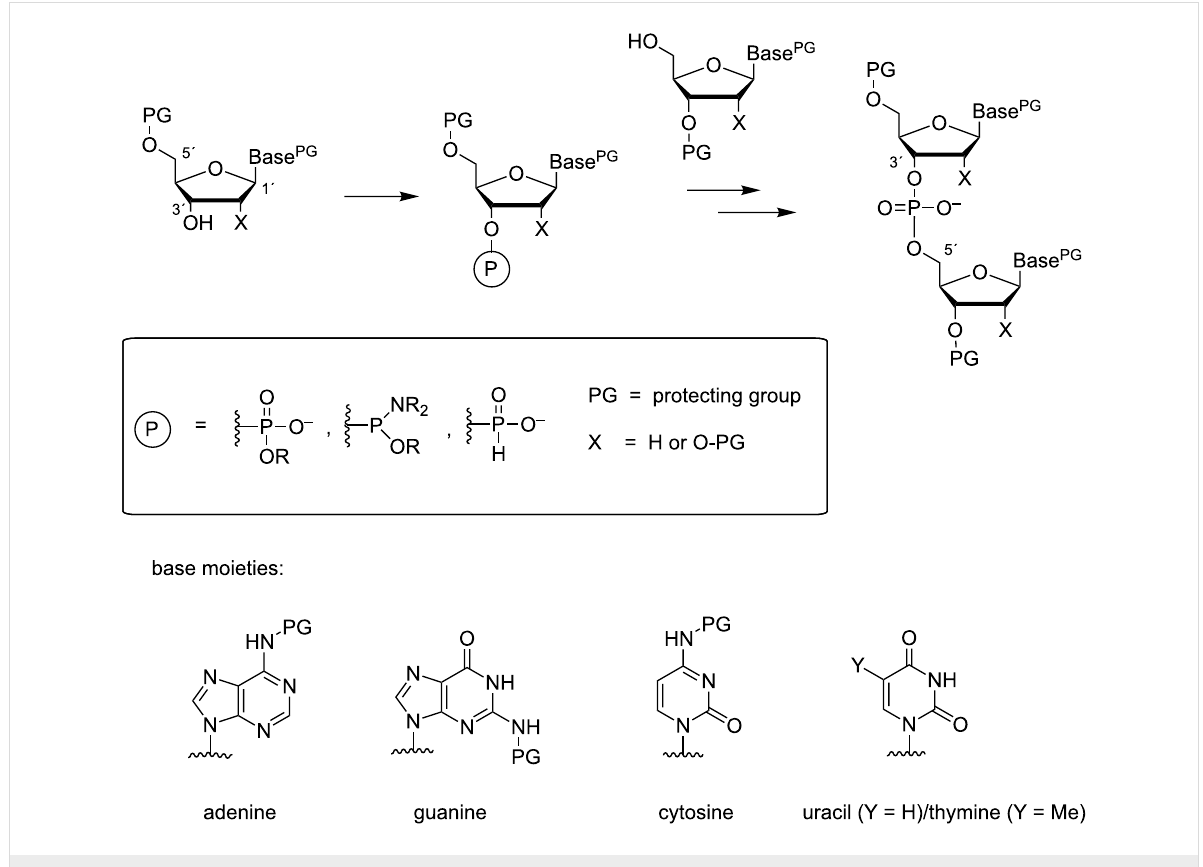
Figure 1: General principle of oligonucleotide